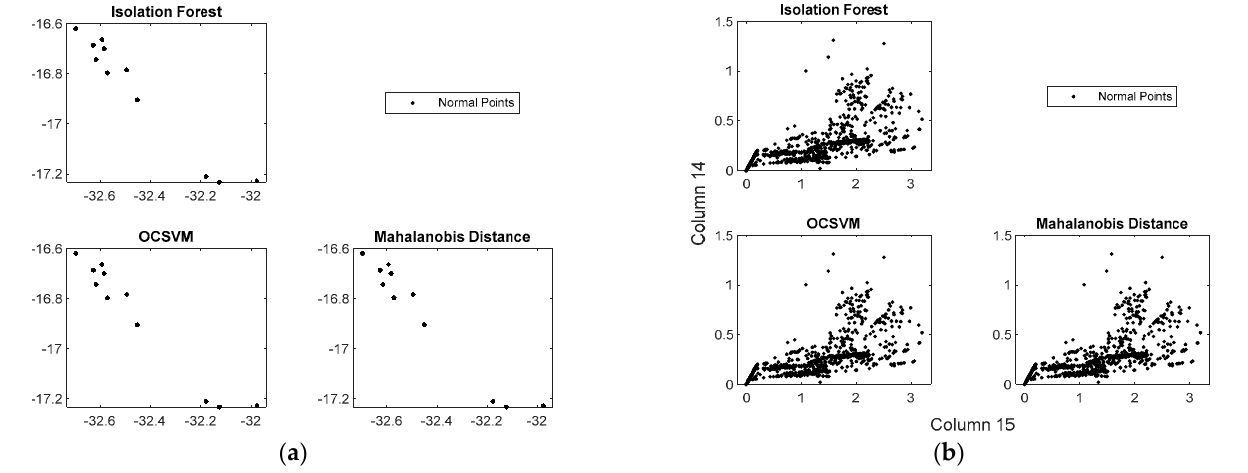
Figure 7. ( a ) Detecting abnormalities in the uncontaminated pHRI-ADL data, ( b ) ranking features.